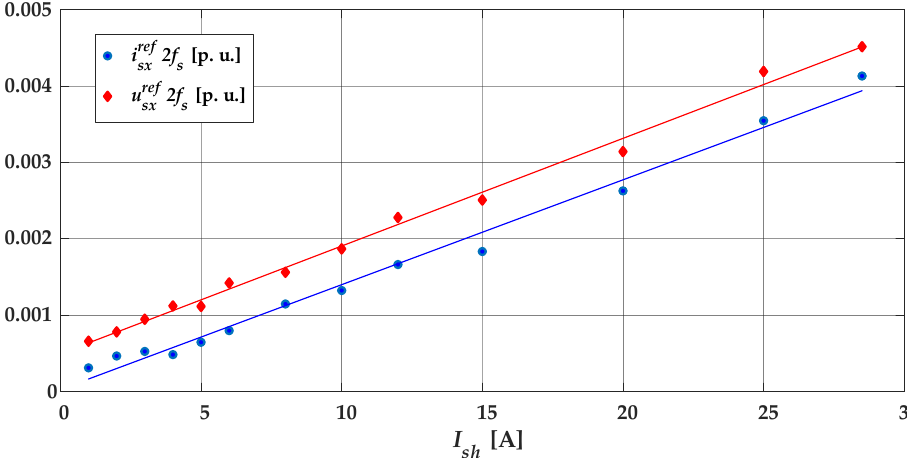
Figure 6. Influence of the short– circuit current value I sh on the amplitude of both analyzed diagnostic